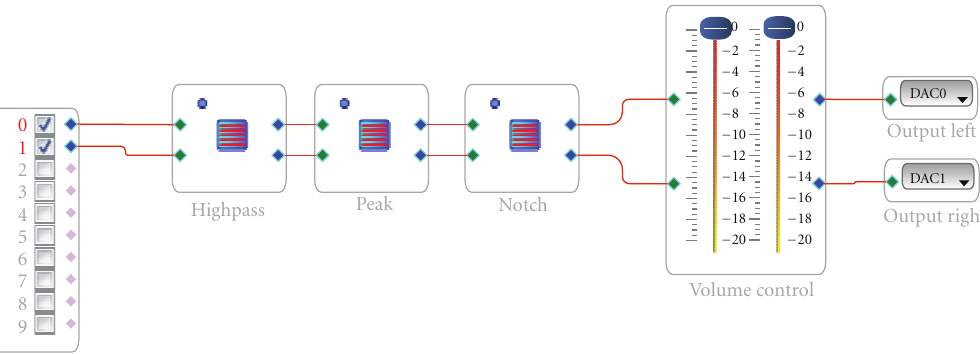
Figure 14: SigmaStudio implementation of the ARA equalizer.